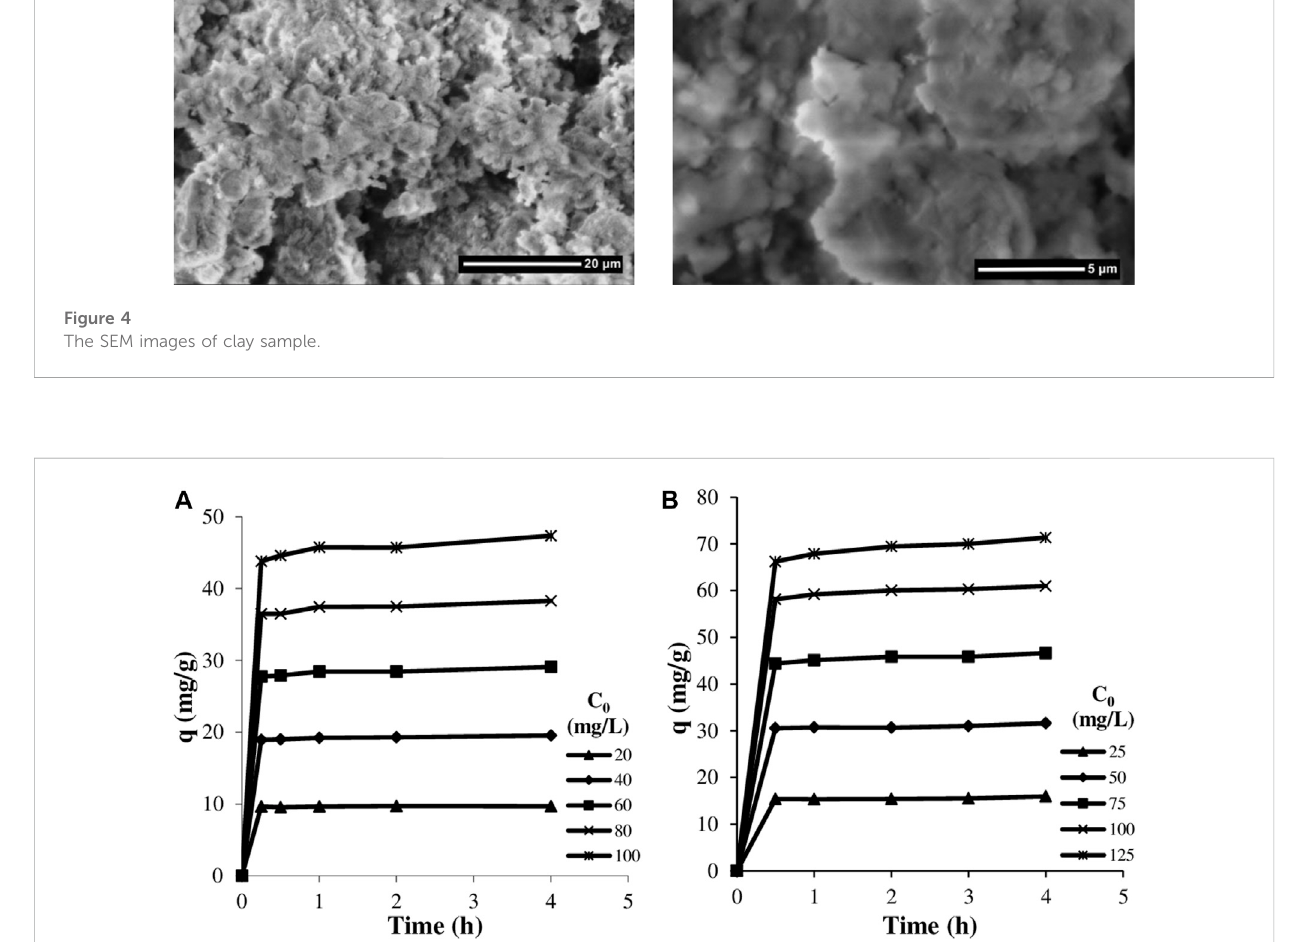
Figure 5 The variation of the amount adsorbed with adsorption time at various initial dye concentrations: astrazon red (A) and astrazon blue (B) .